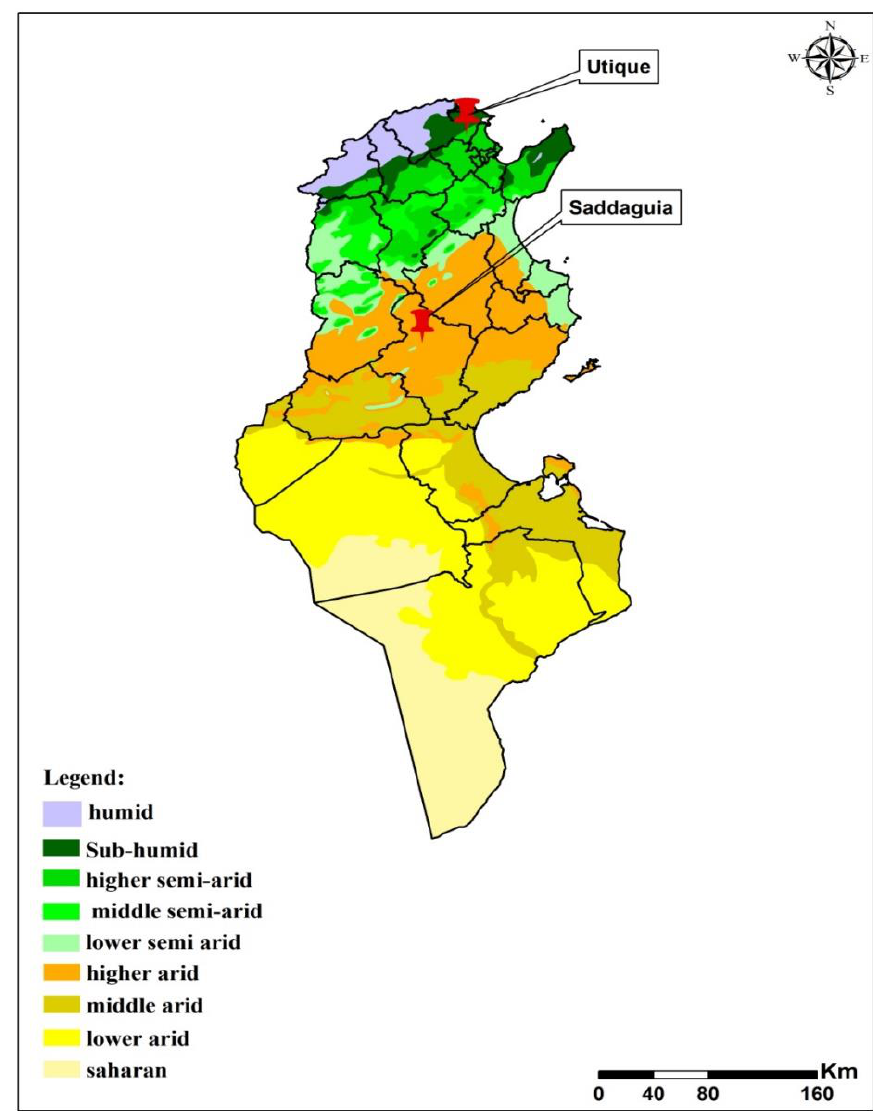
Figure 1. Bioclimatic map of Tunisia showing sandfly sampling sites.